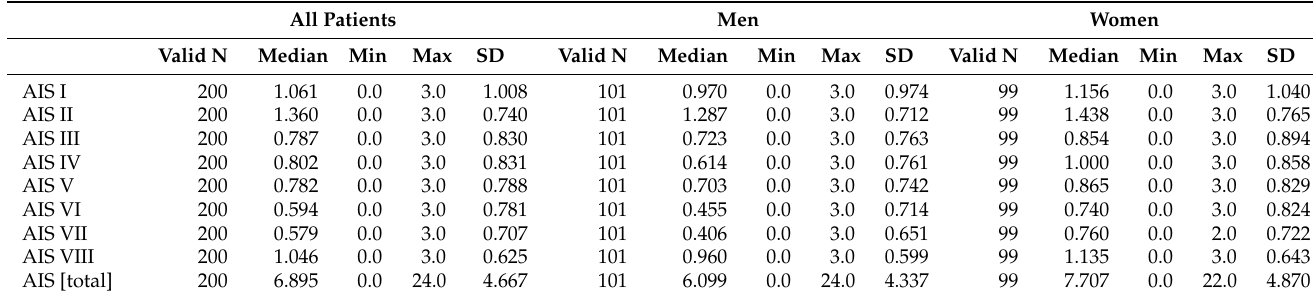
Table 2. Basic characteristics of the results obtained in the AIS incl. division by gender. All Patients Men Women